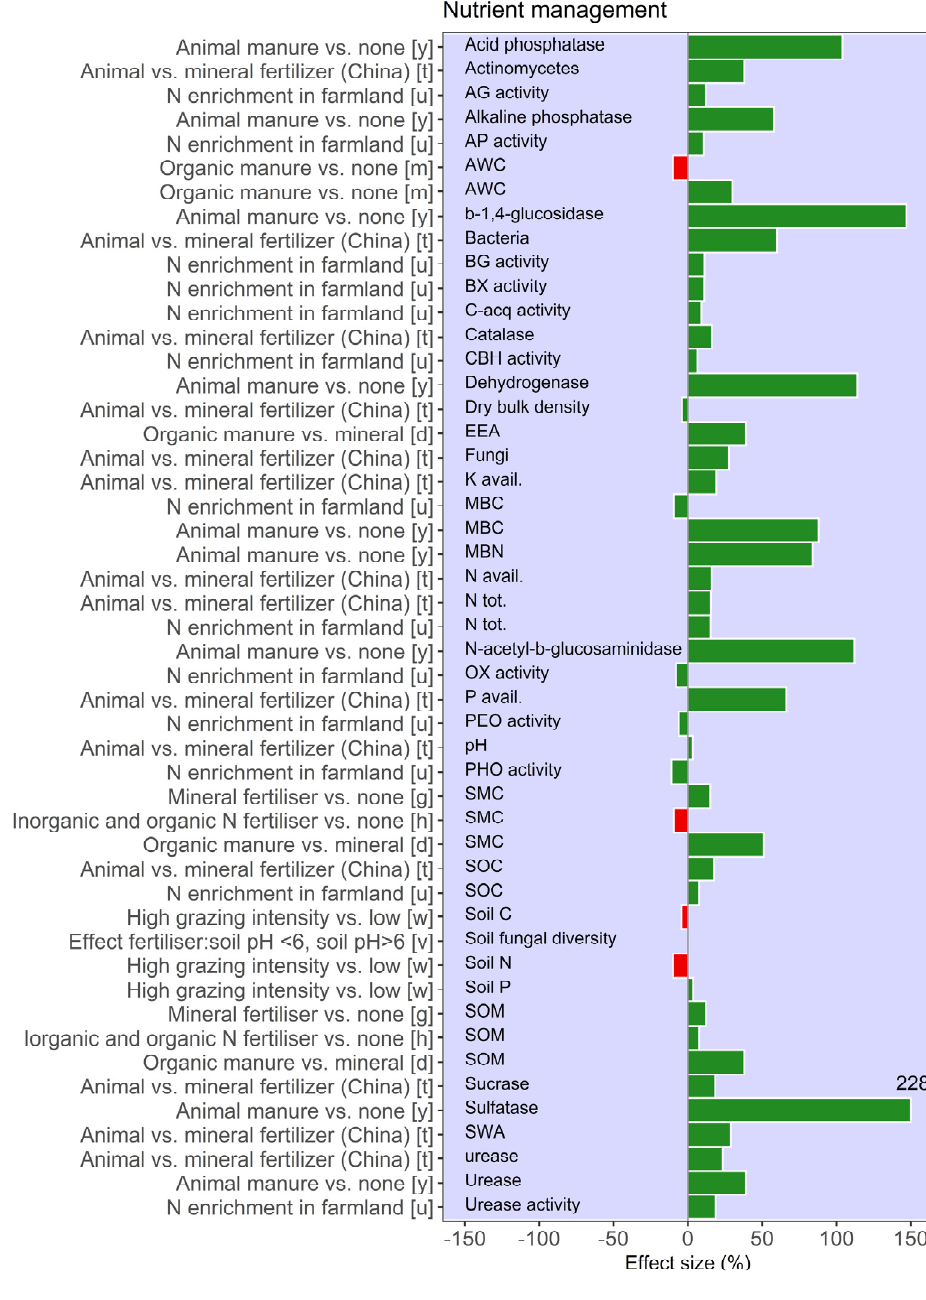
Figure 3. Overall response ratios reported in meta-analysis studies on nutrient management grouped per area of interest (light green: agronomic; light blue: soil quality; light orange: resource use efficiency (no data); light brown: economic (no data); light yellow: environmental impacts). The management or treatment comparison is indicated outside the y-axis and the variable to which the data refer are listed inside the y-axis (abbreviations can be found in Table A1). Green bars indicate improvement, red bars indicate worsening. See also Table S2. [a]: [63] ; [b]: [64] ; [c]: [65] ; [d]: [66] ; [e]: [67] ; [f]: [68] ; [g]: [69] ; [i]: [70] ; [j]: [71] ; [k]: [72] ; [l]: [39] ; [m]: [73] ; [n]: [74] ; [o]: [75] ; [p]: [76] ; [q]: [77] ; [r]: [78] ; [s]: [79] ; [t]: [80] ; [u]: [81] ; [v]: [82] ; [w]: [83] ; [x]: [84] ; [y]: [85] ; [z]: [86] .